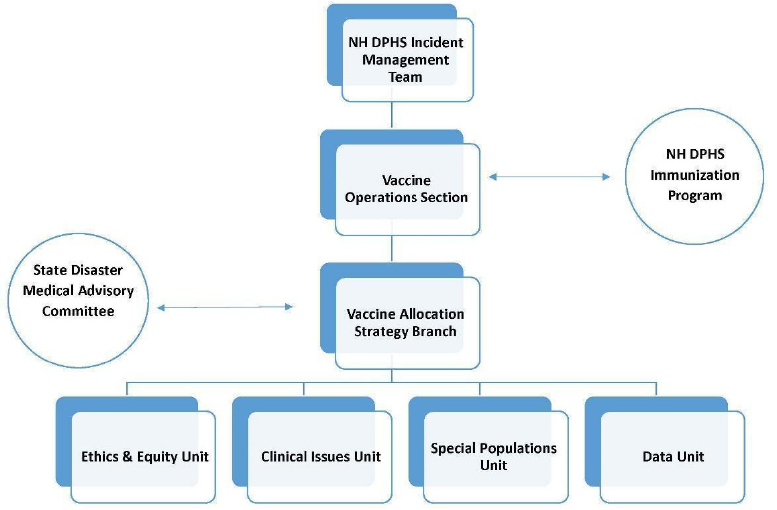
Figure 1. Coronavirus disease 2019 (COVID-19) Vaccine Response Organogram (September 2020). The organogram illustrates only the vaccine allocation segment relevant to the incident com- mand structure and does not show the complete structures of the State of New Hampshire (NH) COVID-19 response, the NH Division of Public Health Services (DPHS) response, and the Vaccine Operations Section. Table 1. Foundational principles of equitable allocation reprinted/adapted with permission from the National Academies of Sciences, Engineering, and Medicine (NASEM) [7]. Copyright 2020, National Academy of Sciences. The Vaccine Allocation Strategy Branch (VASB) utilized these principles for the NH COVID-19 vaccine allocation